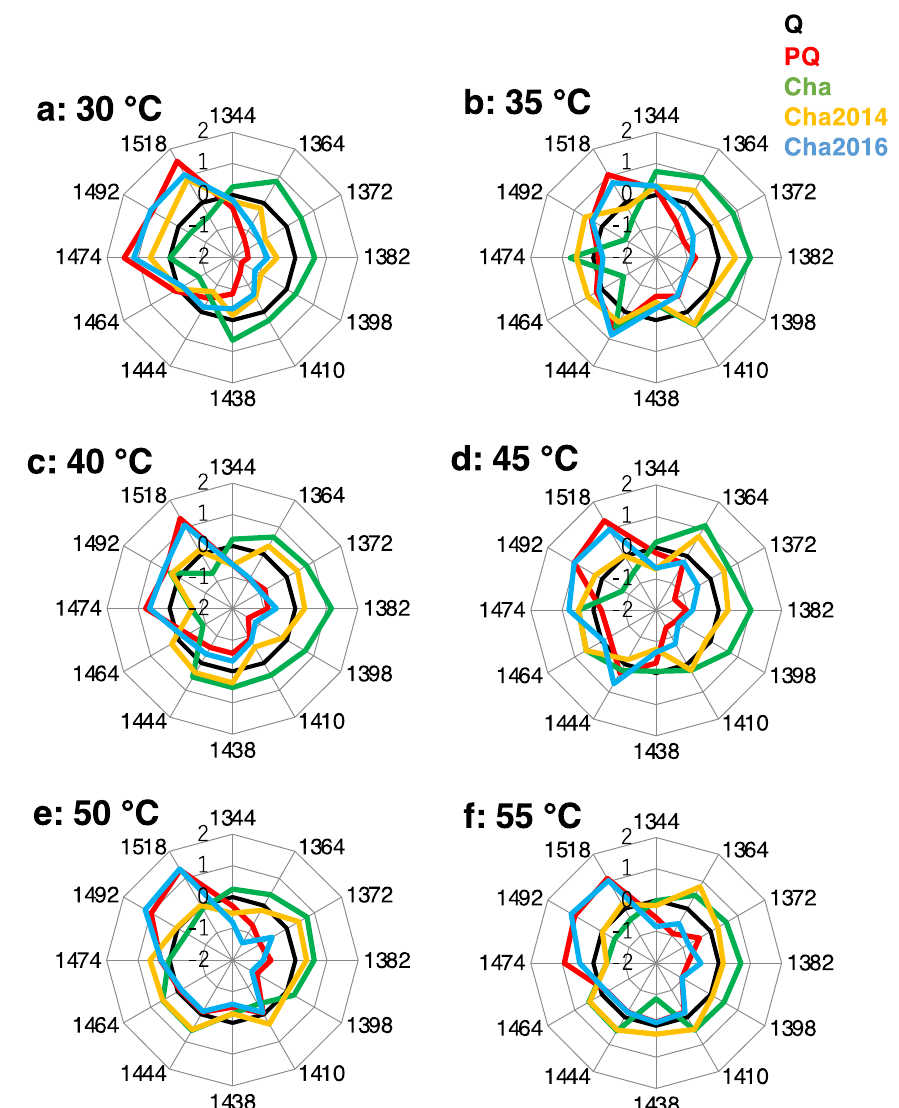
Figure 6. The aquagrams displaying the water absorbance spectral pattern of processed and unpro- cessed waters under temperature perturbation: (( a ) 30 ◦ C; ( b ) 35 ◦ C; ( c ) 40 ◦ C; ( d ) 45 ◦ C; ( e ) 50 ◦ C; and ( f ) 55 ◦ C). Normalized absorbance presented at radial axes is calculated as follows: an average of pure water at all temperatures was subtracted from the averaged spectra of each water at a specific temperature and SNV transformed. Different color of the lines represents different waters (Cha: green, Cha2014: yellow, Cha2016: light blue and PQ: red). Since all waters are being compared to the pure water, central zero line corresponds to the pure water (Q: black). Spectral data are SNV transformed and average Q across all temperatures is subtracted.